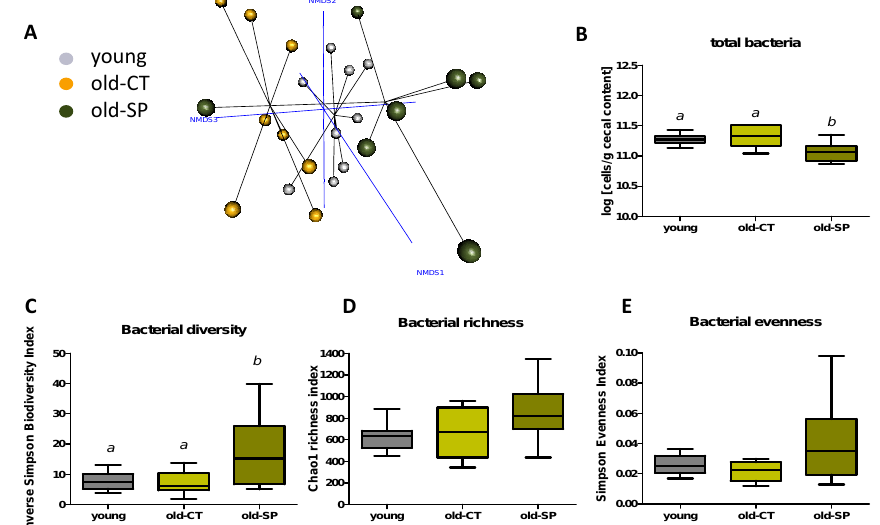
Figure 1. Non-metric dimensional scaling built on a Bray-Curtis distance matrix computed at the species level ( A ); Total bacteria measured by qPCR ( B ); Bacterial diversity deduced from the inverse Simpson Index ( C ); Bacterial richness deduced from the Chao1 Index ( D ); Bacterial evenness deduced from the Simpson Index ( E ). Old mice were fed a standard diet supplemented with or without Spirulina for six weeks and were compared to young mice fed a standard diet. Data of the whiskers plots show the minimum and maximum. Data with different superscript letters are significantly different at p < 0.05 (ANOVA).